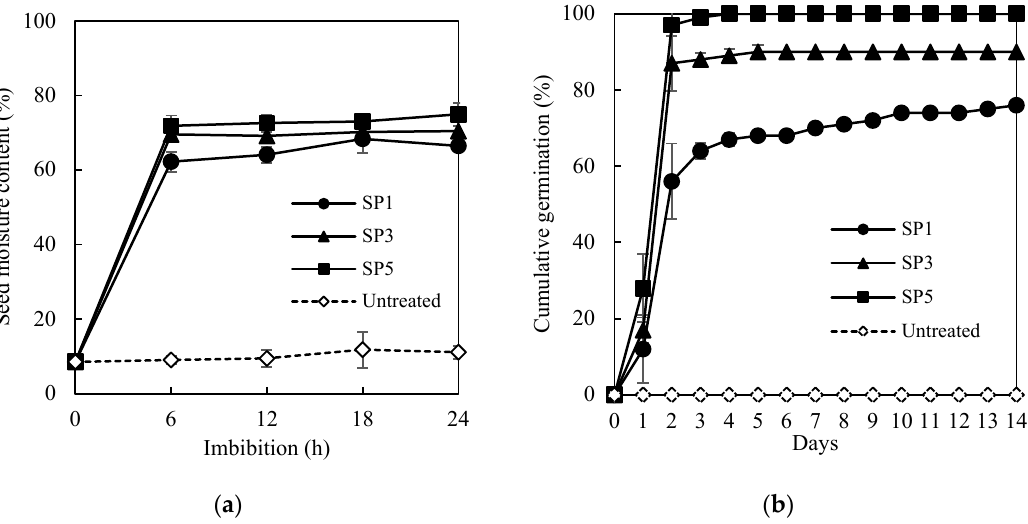
Figure 1. E ff ects of scari fi cation with sandpaper (SP) on the increase in seed moisture content ( a ) Figure 1. Effects of scarification with sandpaper (SP) on the increase in seed moisture content ( a ) and and germination percentage ( b ) of A. sikokianus . Seeds were mechanically scari fi ed by sandpaper germination percentage ( b ) of A. sikokianus . Seeds were mechanically scarified by sandpaper (SP) 1 (SP) 1 (SP1), 3 (SP3), and 5 (SP5) times. Data represent mean of four replicates ± SD. (SP1), 3 (SP3), and 5 (SP5) times. Data represent mean of four replicates ±